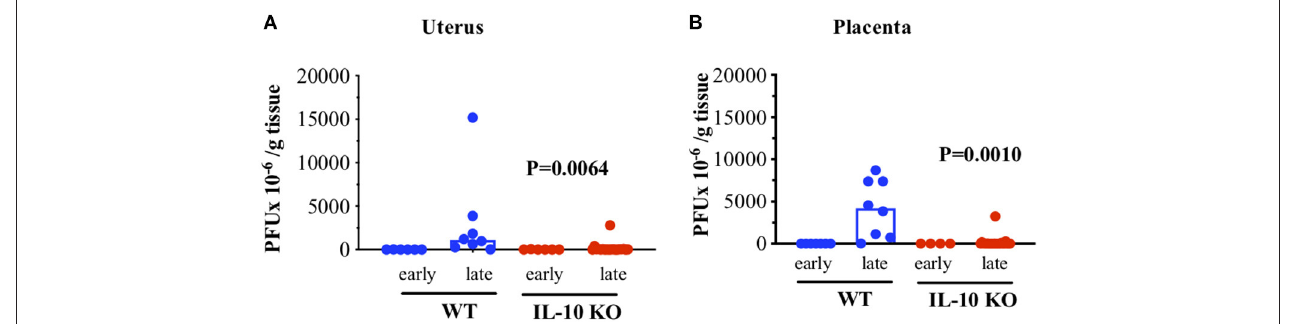
FIGURE 3 | Viral load in WT versus IL-10 KO mice infected with LCMV. WT (C57BL/6) females or IL-10 KO females were mated to same-strain males and on day ∼ 10 of gestation were infected as in Figure 1 and euthanized on days ∼ 12 and ∼ 18 of gestation. Placentas were homogenized and then tested for viral load by plaque assay. (A) Uterine tissues ( n = ∼ 10–20/strain/time). (B) Placental tissues ( n = ∼ 10–20/strain/time). Y axis: PFU × 10 − 6 virus per gram tissue as assessed by plaque assay. X axis: early (2 days post infection or ∼ 12 of gestation) or late (8 days post infection or day ∼ 18 of pregnancy). Each symbol is a unique tissue representing a distinct mother. Blue, WT tissues; Red, IL-10 KO tissues. Bars indicate median for the sample group. p values generated by Kruskal Wallis testing with Dunn’s multiple comparisons test to compare WT vs IL-10 KO late values. Significance set at the p < 0.05 level.